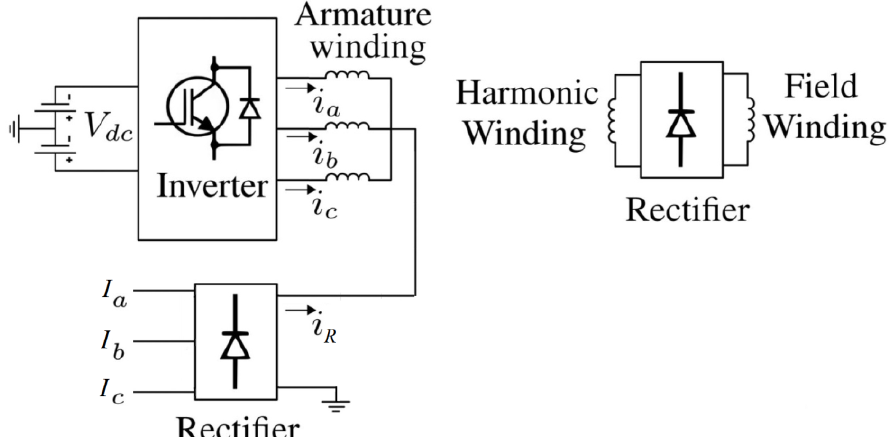
Figure 1. Conventional three-phase rectifier-based brushless WFSM topology.